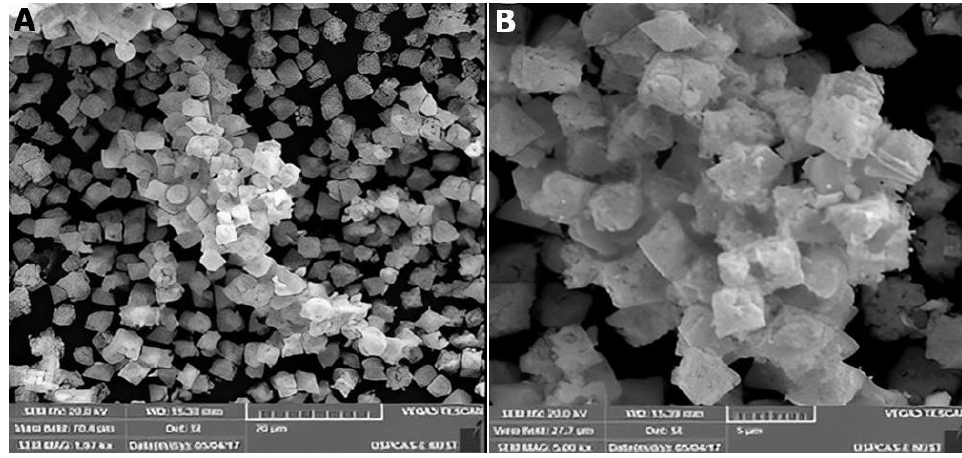
Figure 9. SEM images of rhombohedral ZnO nanostructures grown by the CoP method (( A )—20 µm, ( B )—5 µm). ( B )—5 µ m).